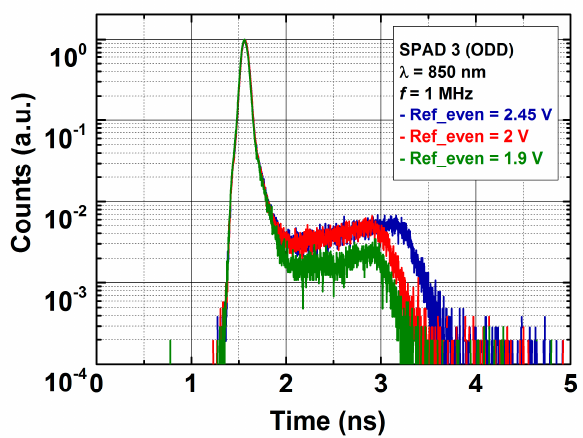
Figure 6. SPAD 3 response to a laser pulse at different external thresholds applied to even SPADs (adjacent to SPAD 3). By reducing the threshold voltage, the overall avalanche quenching time is reduced, leading to a shorter temporal duration of the optical crosstalk. Each curve is normalized to its main peak.